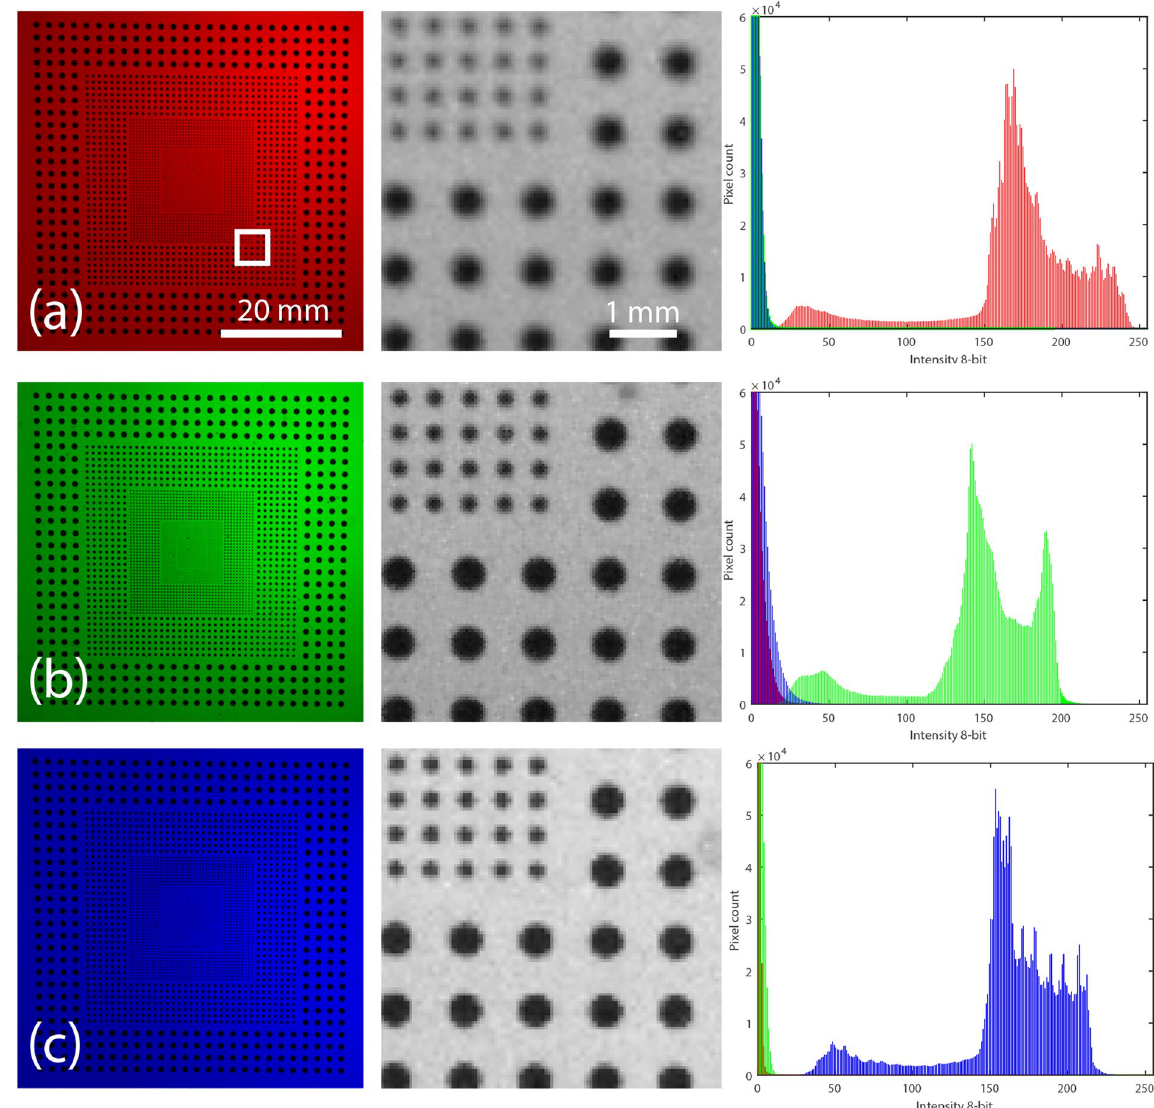
Figure 7. Images of the dotted calibration glass slide inside the water-tank, back-illuminated by red ( a ), green ( b ) or blue ( c ) LED flashes. The middle column images are magnified sections of the dots corresponding to the white square in panel ( a ). On the right column we show the corresponding RGB intensity